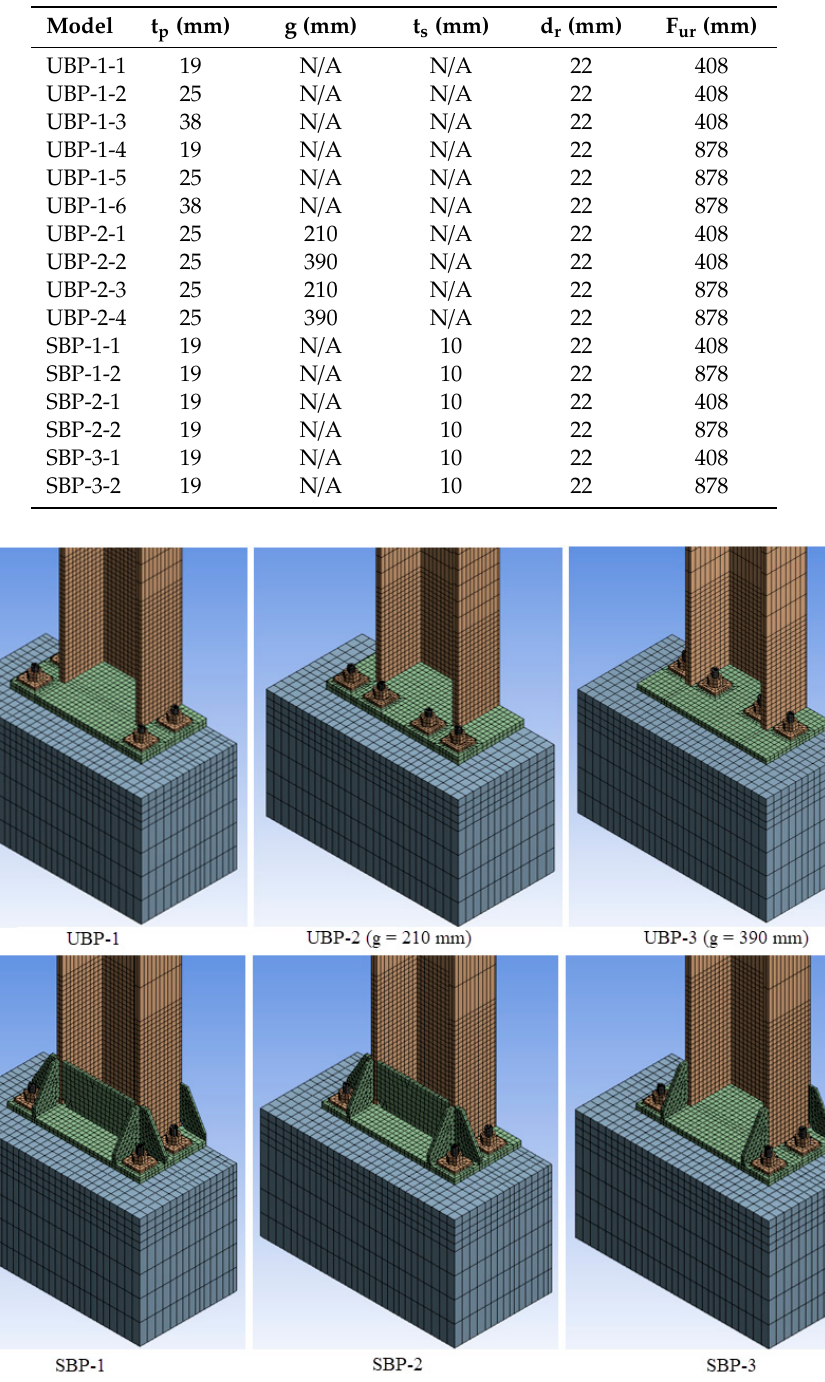
Table 1. Simulations matrix.